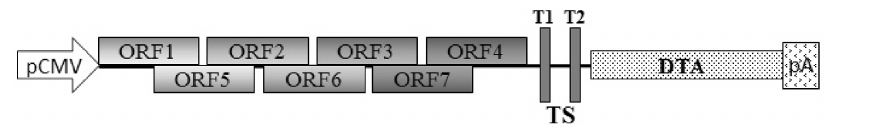
Fig. 3. Structure of the selected UIR construct. Each of the 7 ORFs was , 600 bp long. ORFs 1–4 were in frame 1, ORFS 5–7 were in frame 2, and the DTA transgene ORF was in the 3 rd frame. T1 and T2 are target sites (TS) for siRNAs. In constructs containing target sites for miRNAs there were usually 3 target sites. Full sequence and information on this construct, with target sites for siRNAs S4 and S5 can be found in the supplementary information).